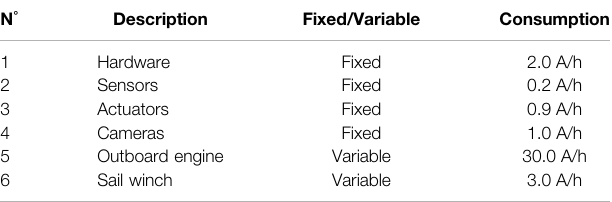
TABLE 2 | Calculated energy